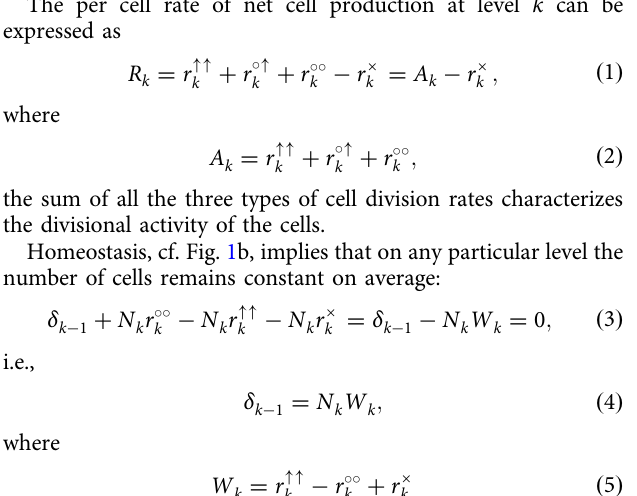
The proliferative disadvantage of cells is determined by the ampli fi cation factor . A differentiation hierarchy H with n + 1 levels and N 0 stem cells is fully described by the per cell rates of the four microscopic events: symmetric differentiation ( r (cid:2)" asymmetric differentiation ( r ), symmetric cell division ( r (cid:2)(cid:2) k and cell death ( r ´ ) for each level k (Fig. 1a), which together k specify the homeostatic cell numbers N k at each level k (Fig. 1b).